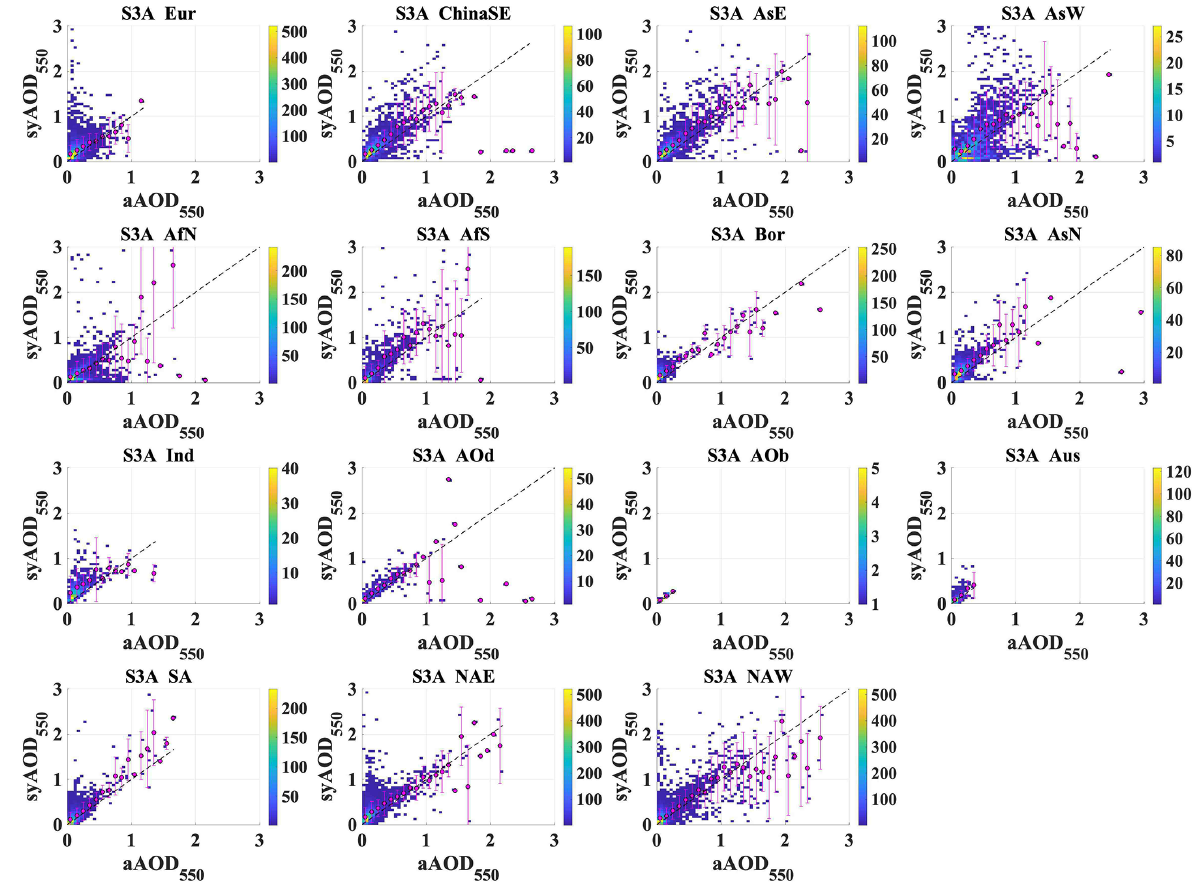
Figure 7. For S3A, syAOD and aAOD scatter density plots for selected regions (as defined in Fig. 6).